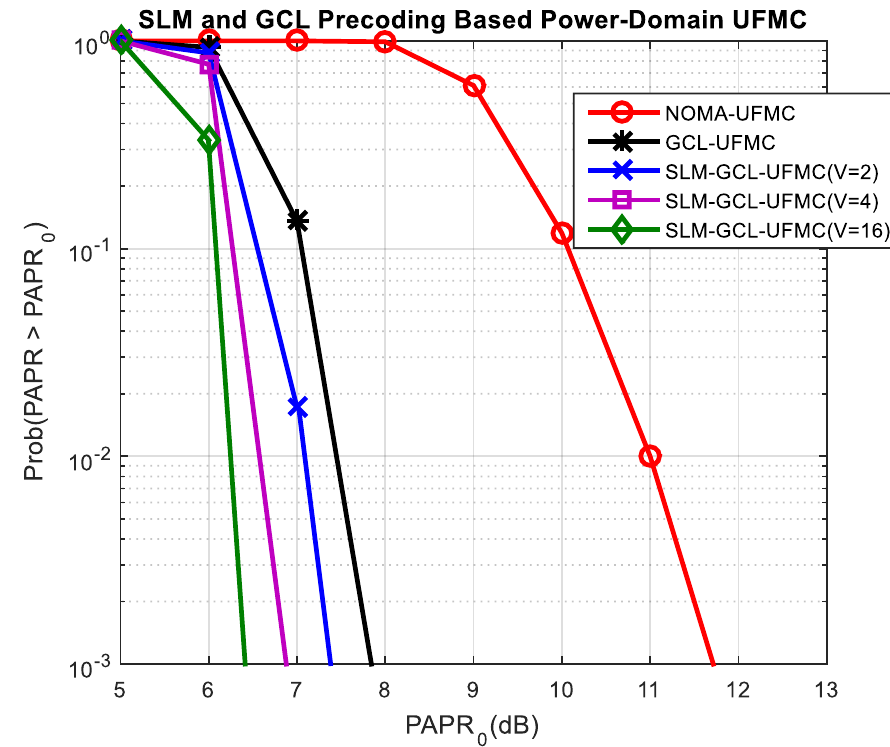
Figure 3. Peak-to-average power ratio (PAPR) analysis using 4-QAM.